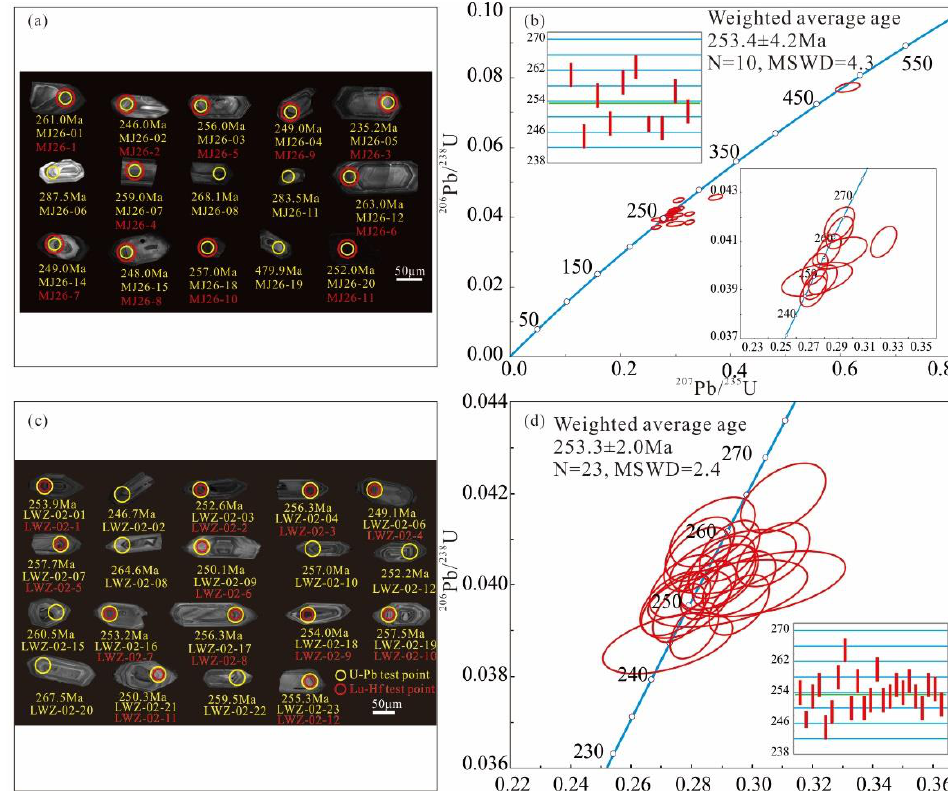
Figure 6. ( a ) Cathodoluminescence (CL) images of zircons of the rhyolite (MJ-26); ( b ) LA-ICP-MS zircon U-Pb concordia diagram of the rhyolite (MJ-26); ( c ) Cathodoluminescence (CL) images of zircons of the granite porphyry (LWZ-02); ( d ) LA-ICP-MS zircon U-Pb concordia diagram of the granite porphyry (LWZ-02).